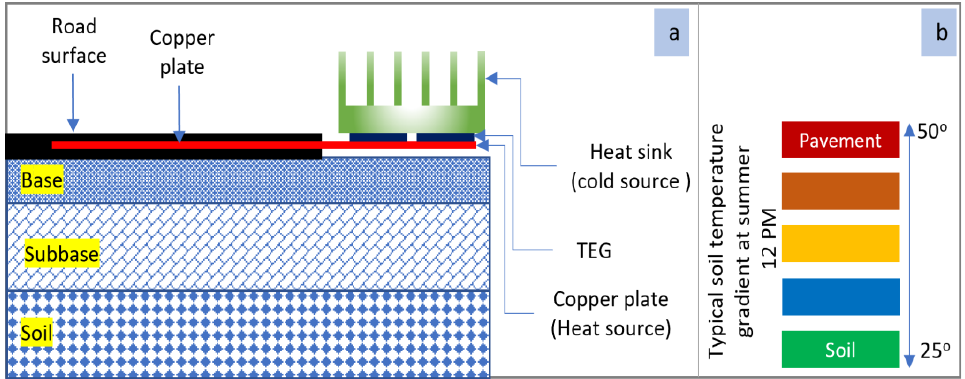
Figure 12. ( a ) Typical thermoelectric energy harvesting system in pavement [86,87] ( b ) temperature distribution in asphalt pavement [88,89]. (This drawing was created by the authors).